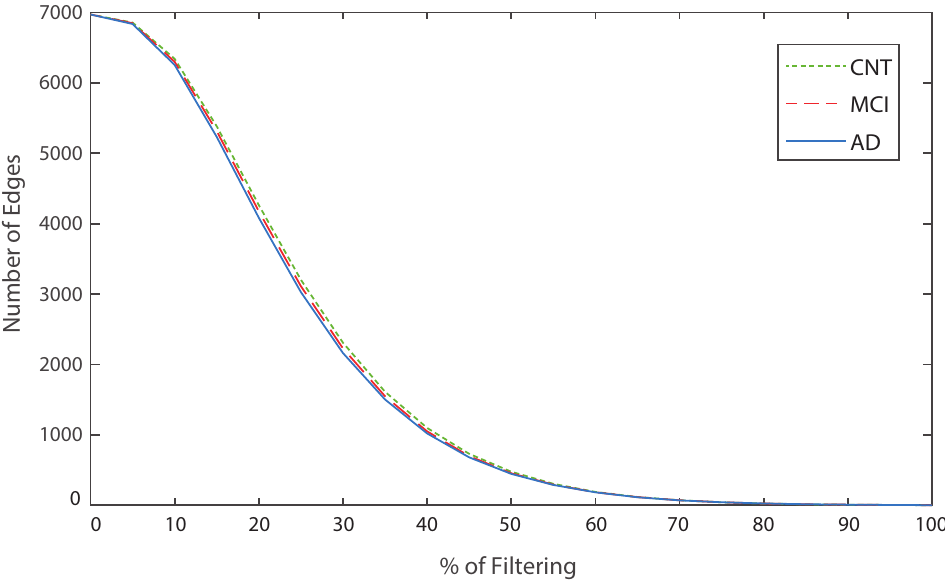
Figure 3. Trend of the number of edges computed by thresholding the connection matrices of control subjects (CNT), Mild Cognitive Impairment patients (MCI), and Alzheimer’s Disease patients (AD), reported in Table 2.